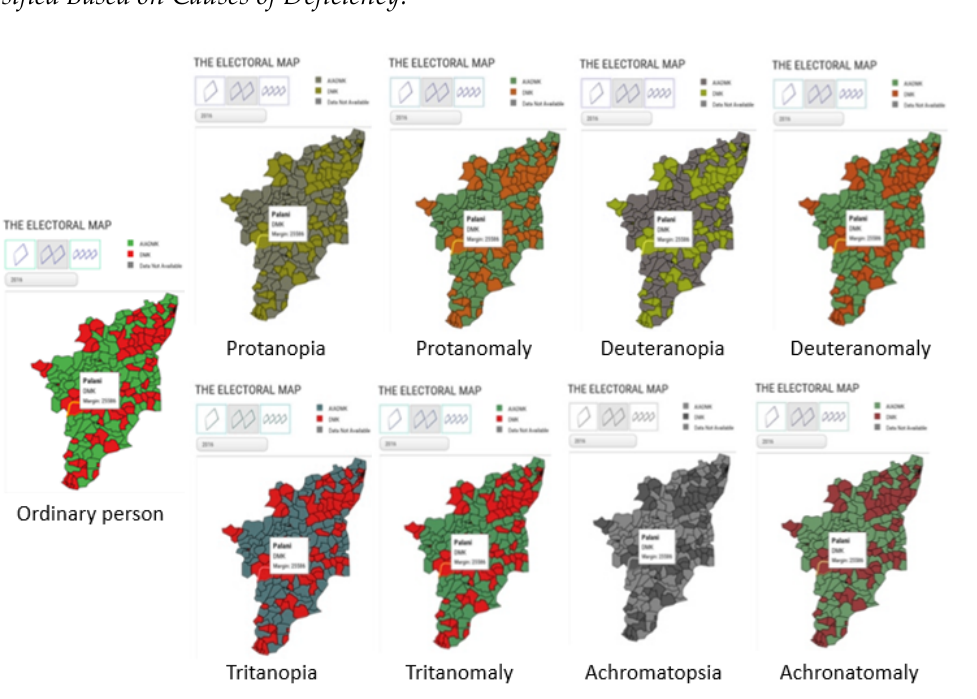
Figure 15: Comparison for Visual Perception of Ordinary Person and Person Having Visual Deficiencies Classified Based on Causes of